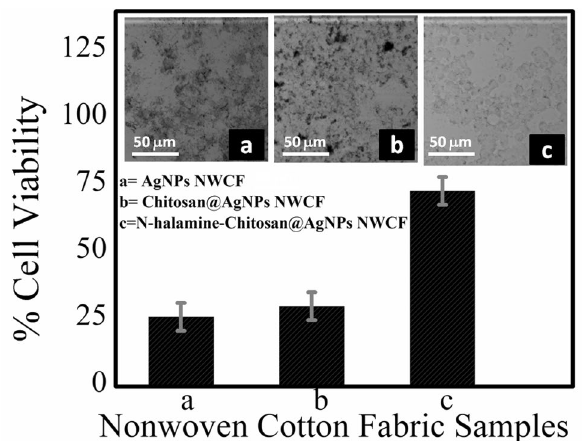
Figure 7. Cell viability analysis (MTT assay) on Hela Cell lines of AgNPs-NWCF, Chitosan@AgNPs-NWCF, N-halamine- Chitosan@AgNPs-NWCF. Inside images show confocal microscopic cell